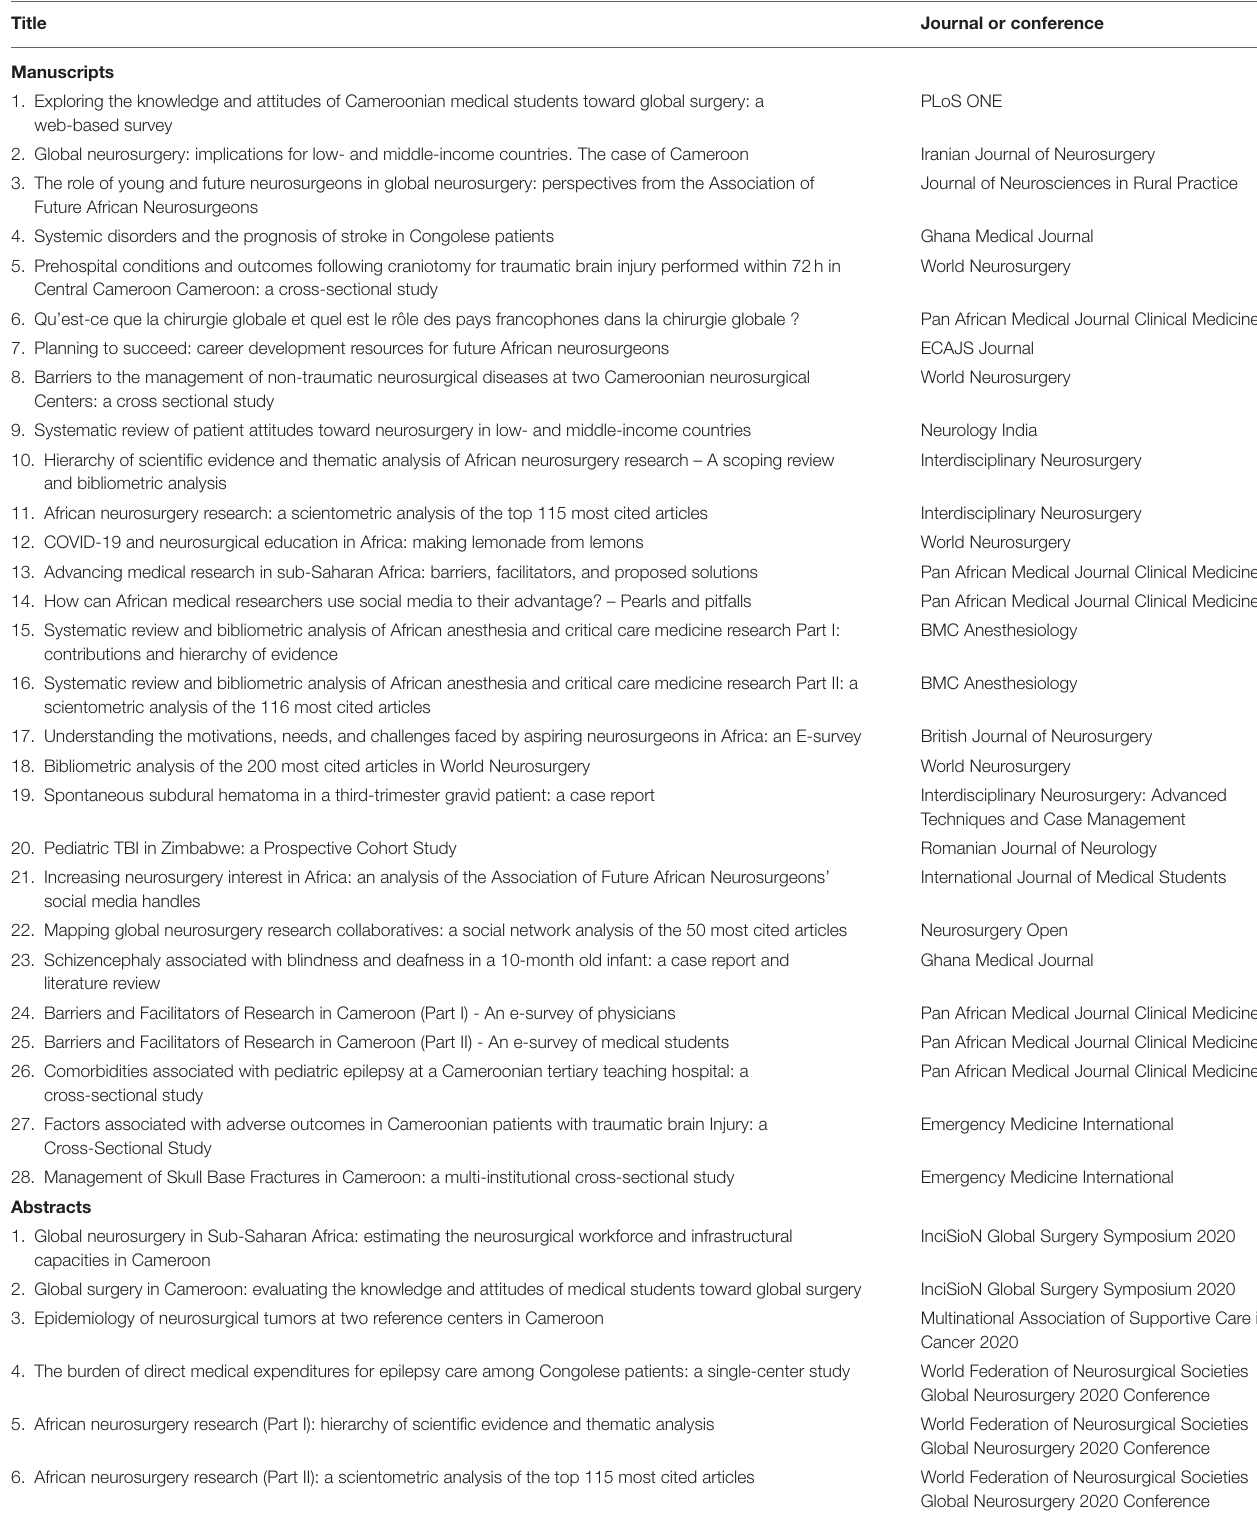
TABLE 2 | Scholarly output of the AFAN research incubator